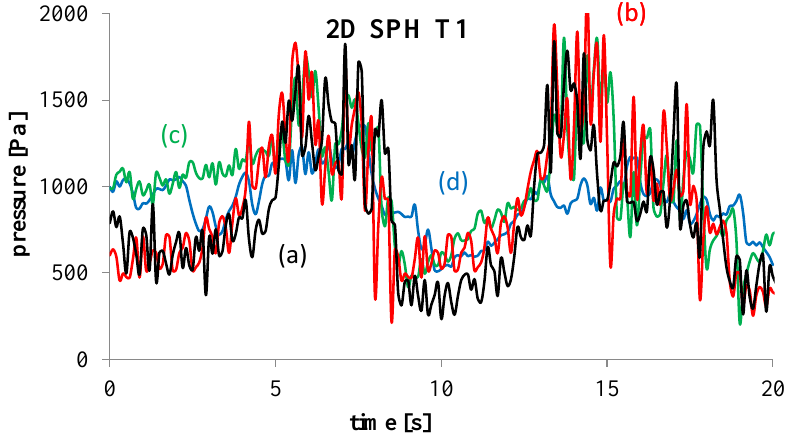
Figure 16. Time series of the pressure under hydraulic jump (configuration: T1) at a distance of: ( a ) 7 cm;